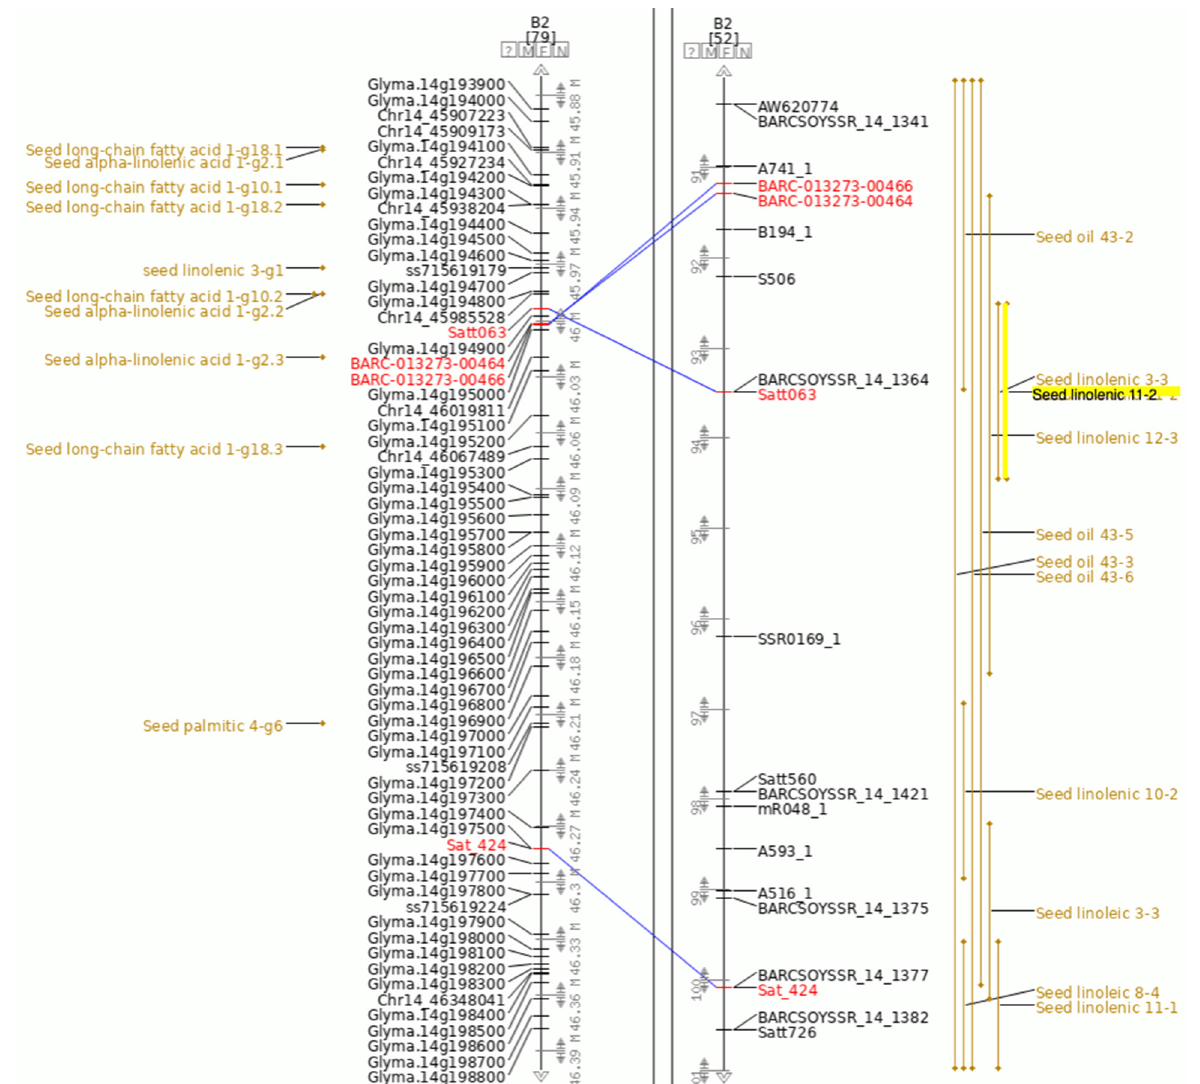
Figure 3. Genetic and physical map region containing Seed linolenic 11-2. Region of the physical and genetic map of MLG B2/Gm14 containing Seed linolenic 11-2. Only seed oil QTL are pictured for clarity. The physical map ( left ) includes the locations of gene models (Glyma.14g194300). The composite map ( right ) contains QTL regions for seed oil related QTL. Sequence based markers that have been genetically mapped are connected by blue lines. Larger version.